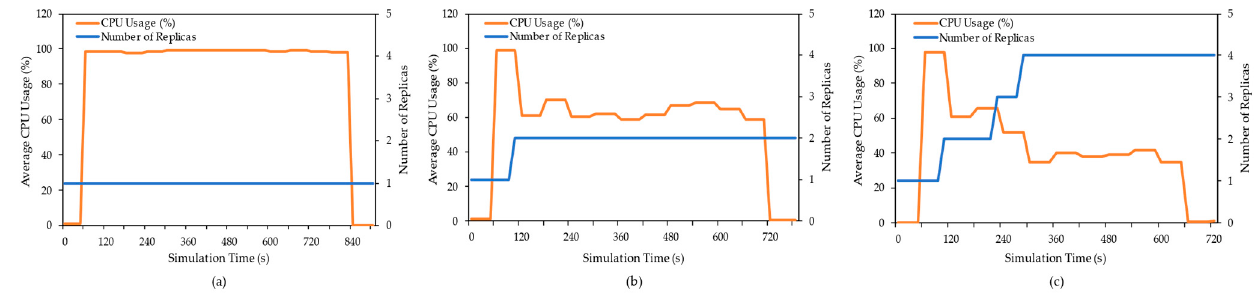
Figure 5. Total time for remote deployment and setup time for (a) 1 replica, (b) 2 replicas, and (c) 4 replicas.